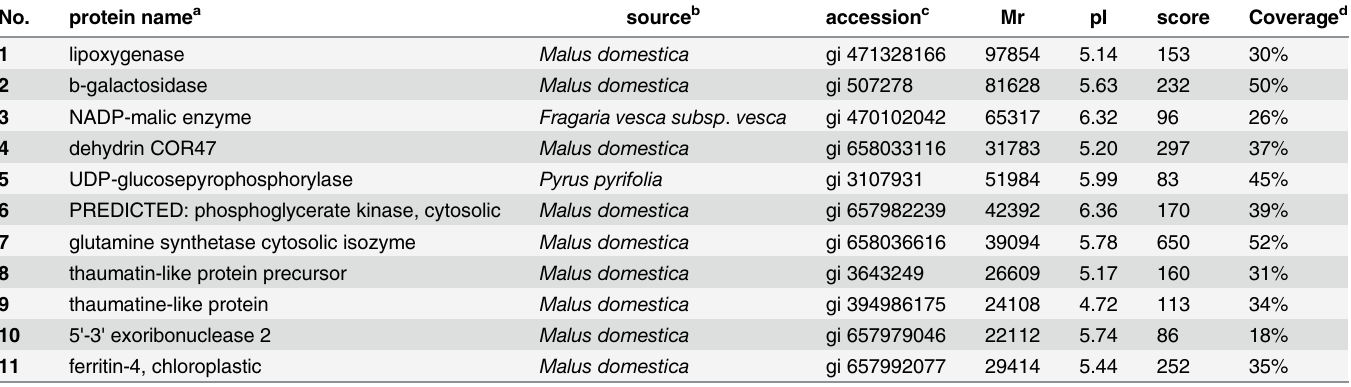
Table 1. Senescence related proteins in apple pulp discs identified by MALDI-TOF/TOF. No.